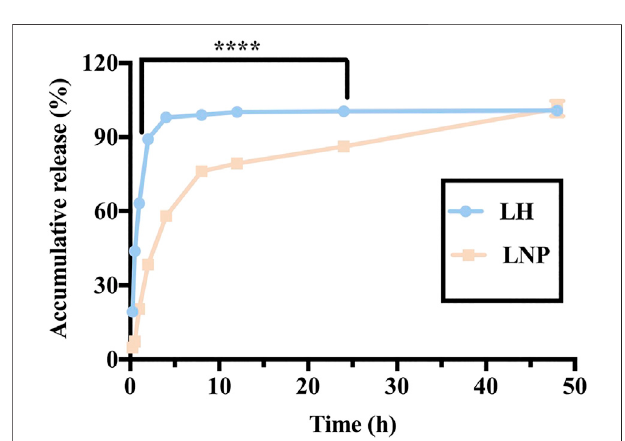
FIGURE 5 | In vitro release pro fi le of LH and LNPs. **** p < 0.0001 by one-way ANOVA with Tamhane ’ s